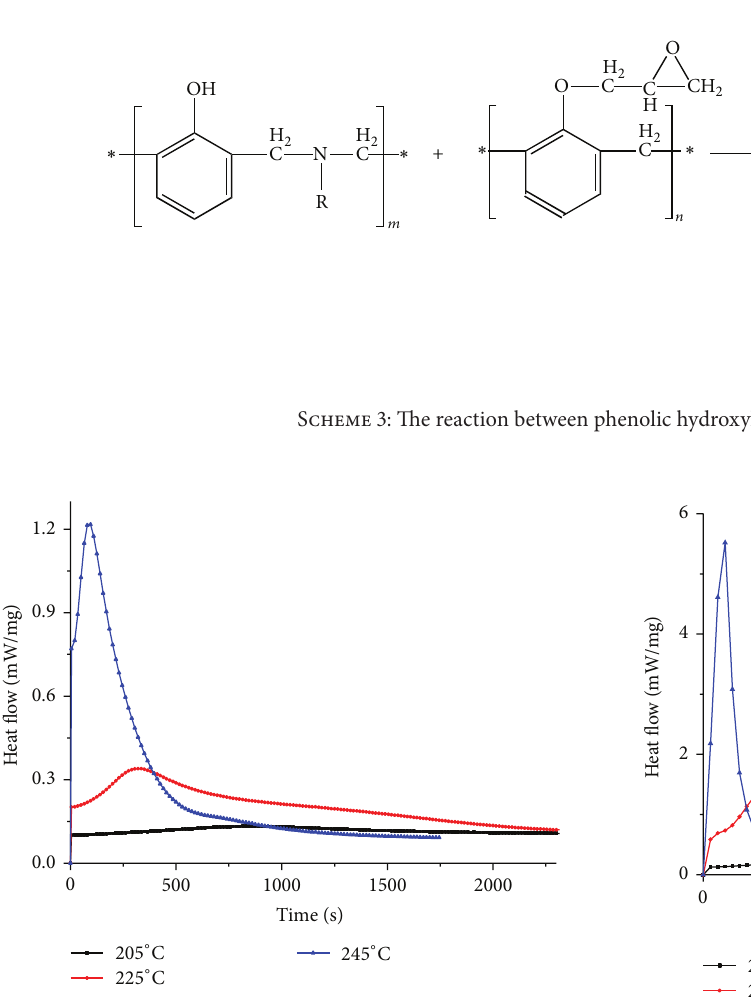
Figure 2: Isothermal curing DSC curves of BZ